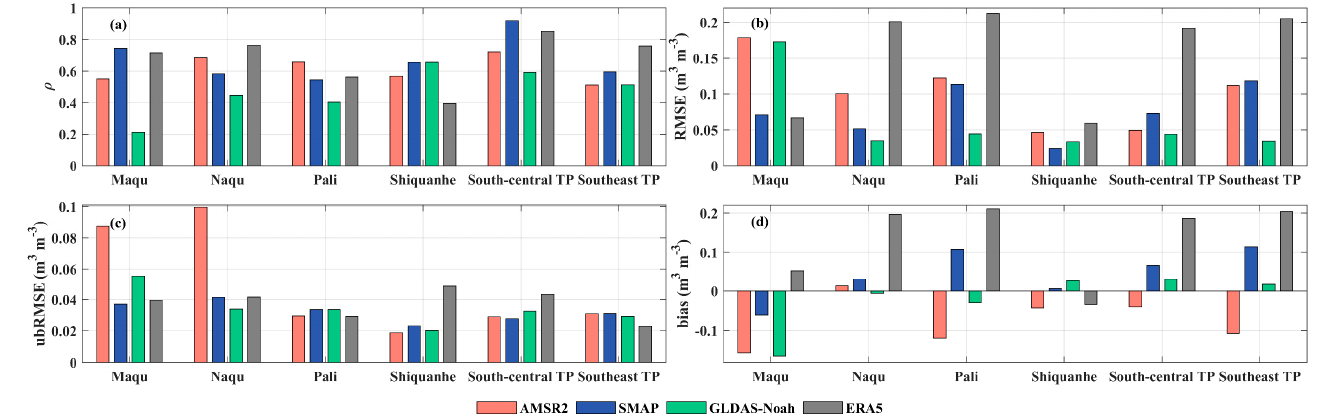
Figure 5. The ( a ) ρ , ( b ) RMSE , ( c ) ubRMSE , and ( d ) bias values of AMSR2, SMAP, GLDAS-Noah, and ERA5 SM for Maqu network, Naqu network, Pali network, Shiquanhe network, south-central TP, and southeast TP in April–October during 2015–2016.